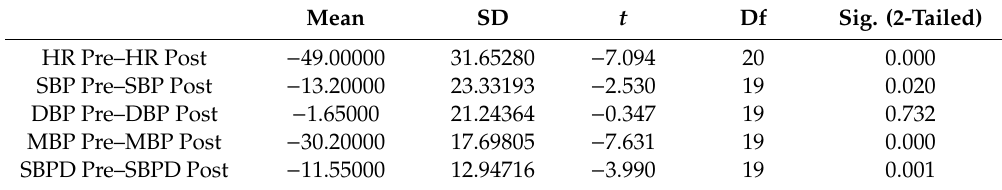
Table 3. Paired t -test comparison of pre- and post-exercise blood pressure variables. Mean SD t Df Sig.